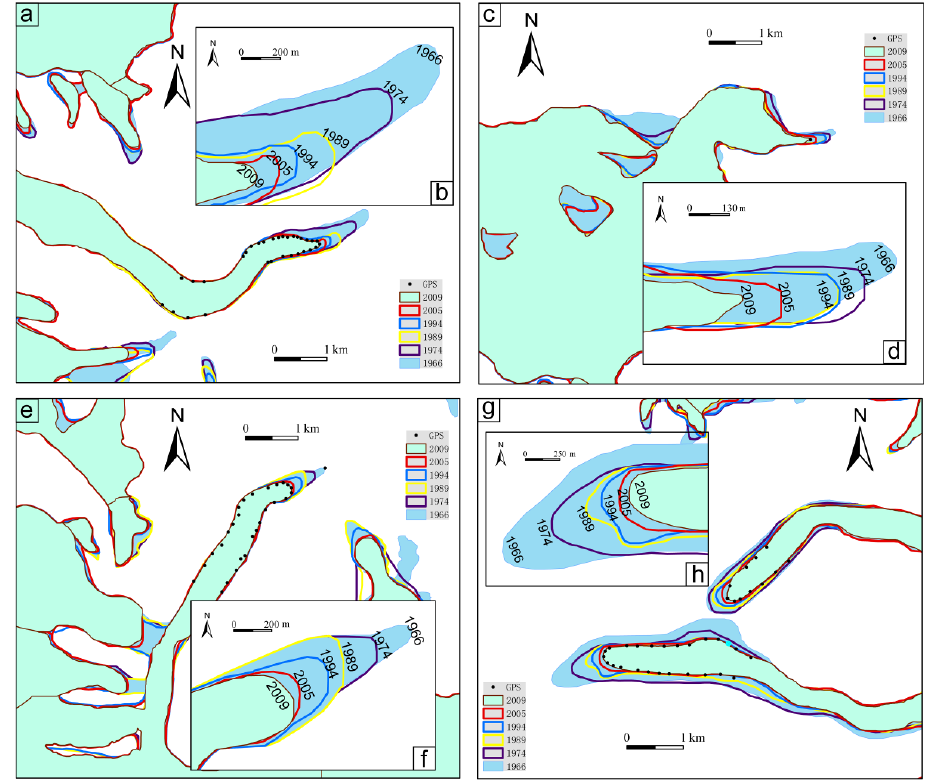
Fig. 2. Area changes and terminal retreat of the HLG ( a and b ), MZG ( c and d ), YZG ( e and f ) and DGB ( g and h ) Glaciers since 1966. Table 3. Results of glacier mapping in 1966–2009. Time Glacier Total area Mean glacier area Area change* Rate of area change count (km 2 ) (km 2 ) (km 2 ) (km 2 yr − 1 ) 1966 74